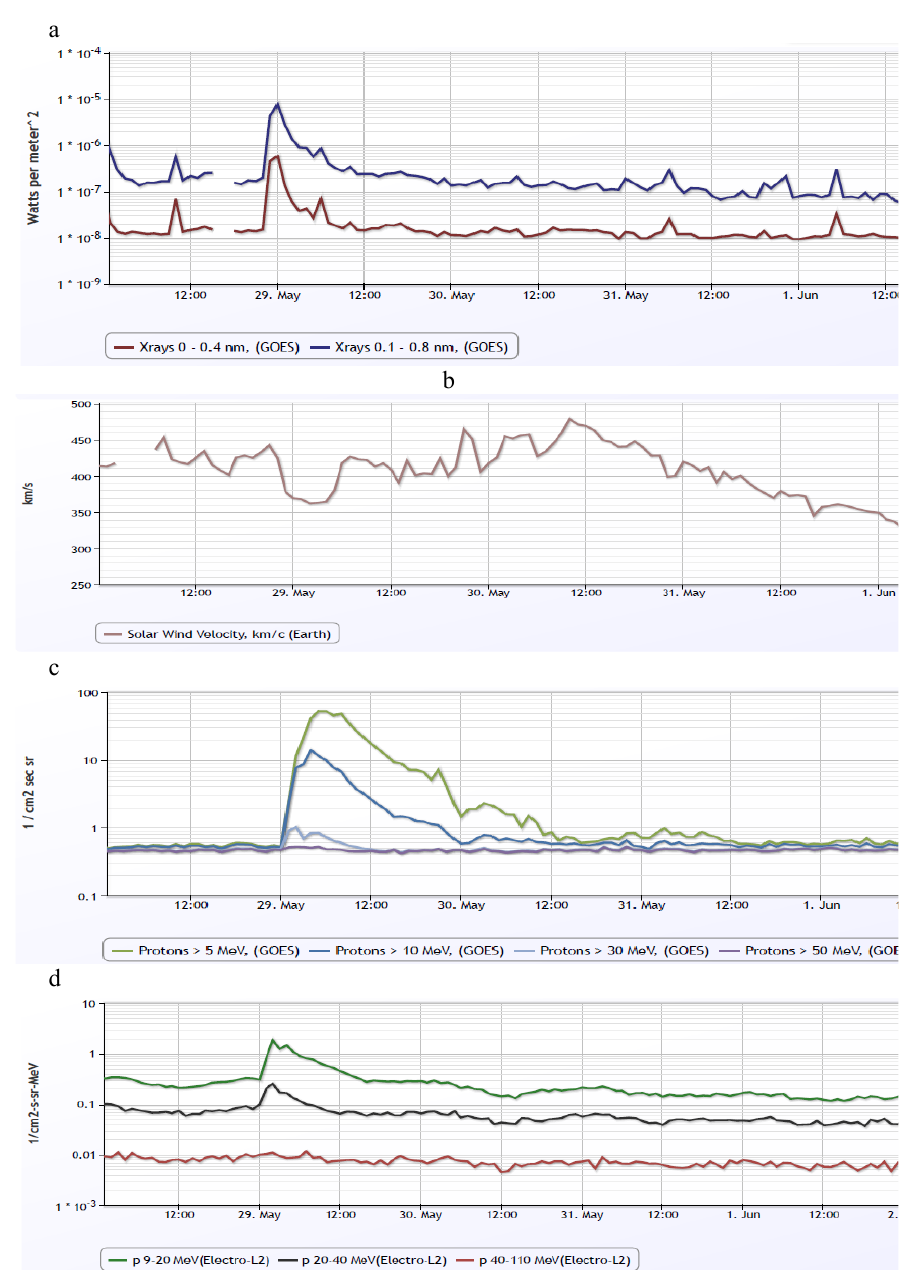
Fig. 7. Time profiles of solar X-rays (а), SW velocity (b) and solar proton fluxes at geostationary orbit (c, d) during 28.05 - 02.06